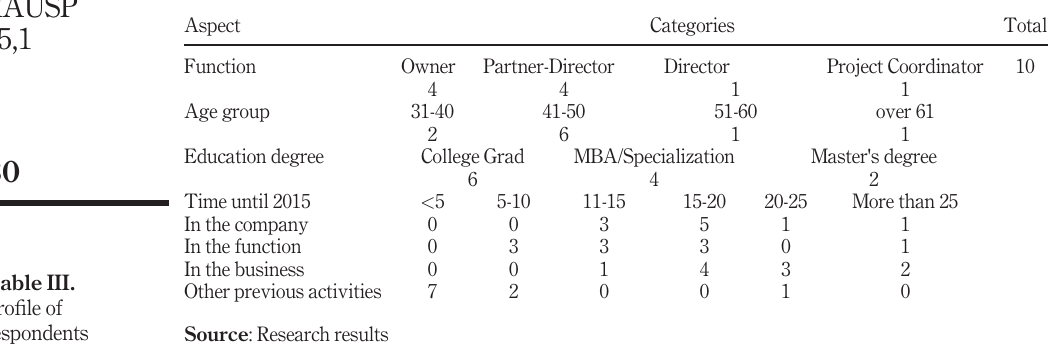
Table III. Pro fi le